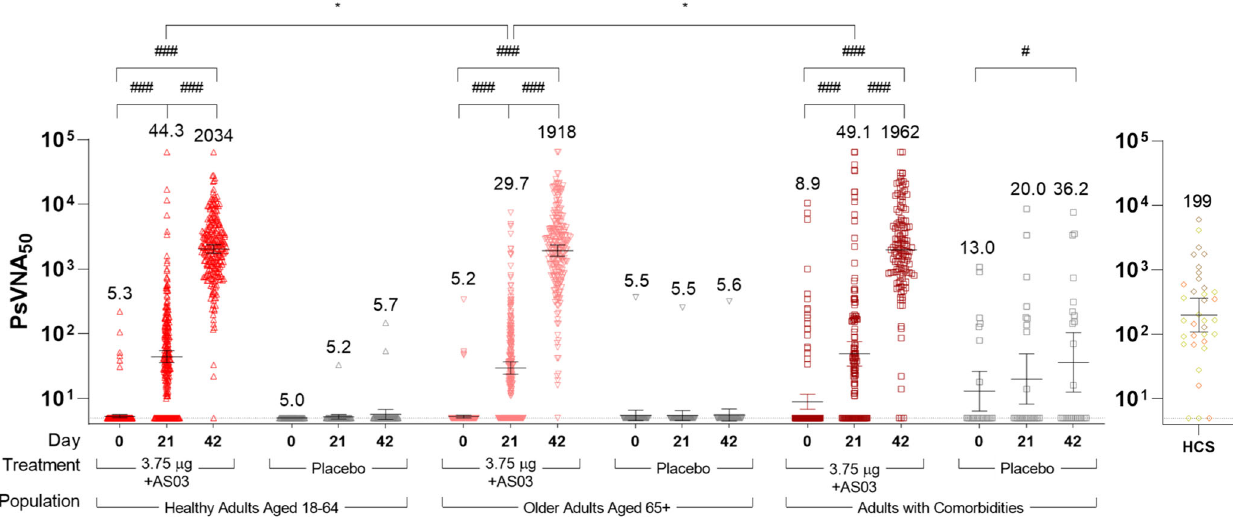
Fig. 3 Humoral response in Healthy Adults, Older Adults, and Adults with Comorbidities. Pseudovirion neutralization titers at baseline (Day 0) and 21 days after the fi rst dose (Day 21) or the second dose (Day 42) of either CoVLP + AS03 or placebo. Bars and numerical values indicate geometric means and error bars indicate 95CI. Signi fi cant differences between Days 0, 21 and 42 are indicated by # ( ### p < 0.001; paired T-test of log-transformed values, SAS). Signi fi cant differences across study populations at D21 or D42 are indicated by * (* p < 0.05; one-way ANOVA on log-transformed data for GMT, SAS). HCS: Human convalescent